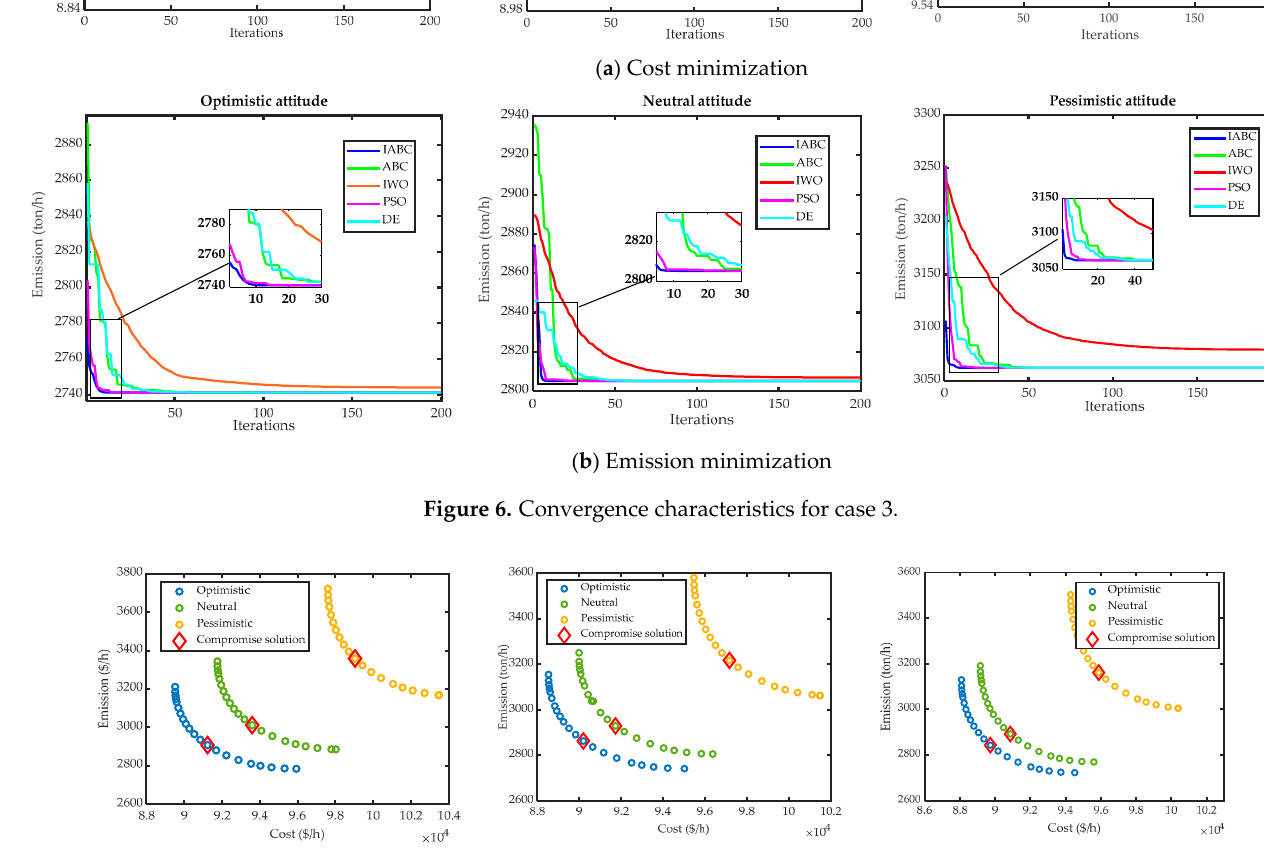
Figure 7. Pareto fronts in terms of dispatcher’s attitudes.